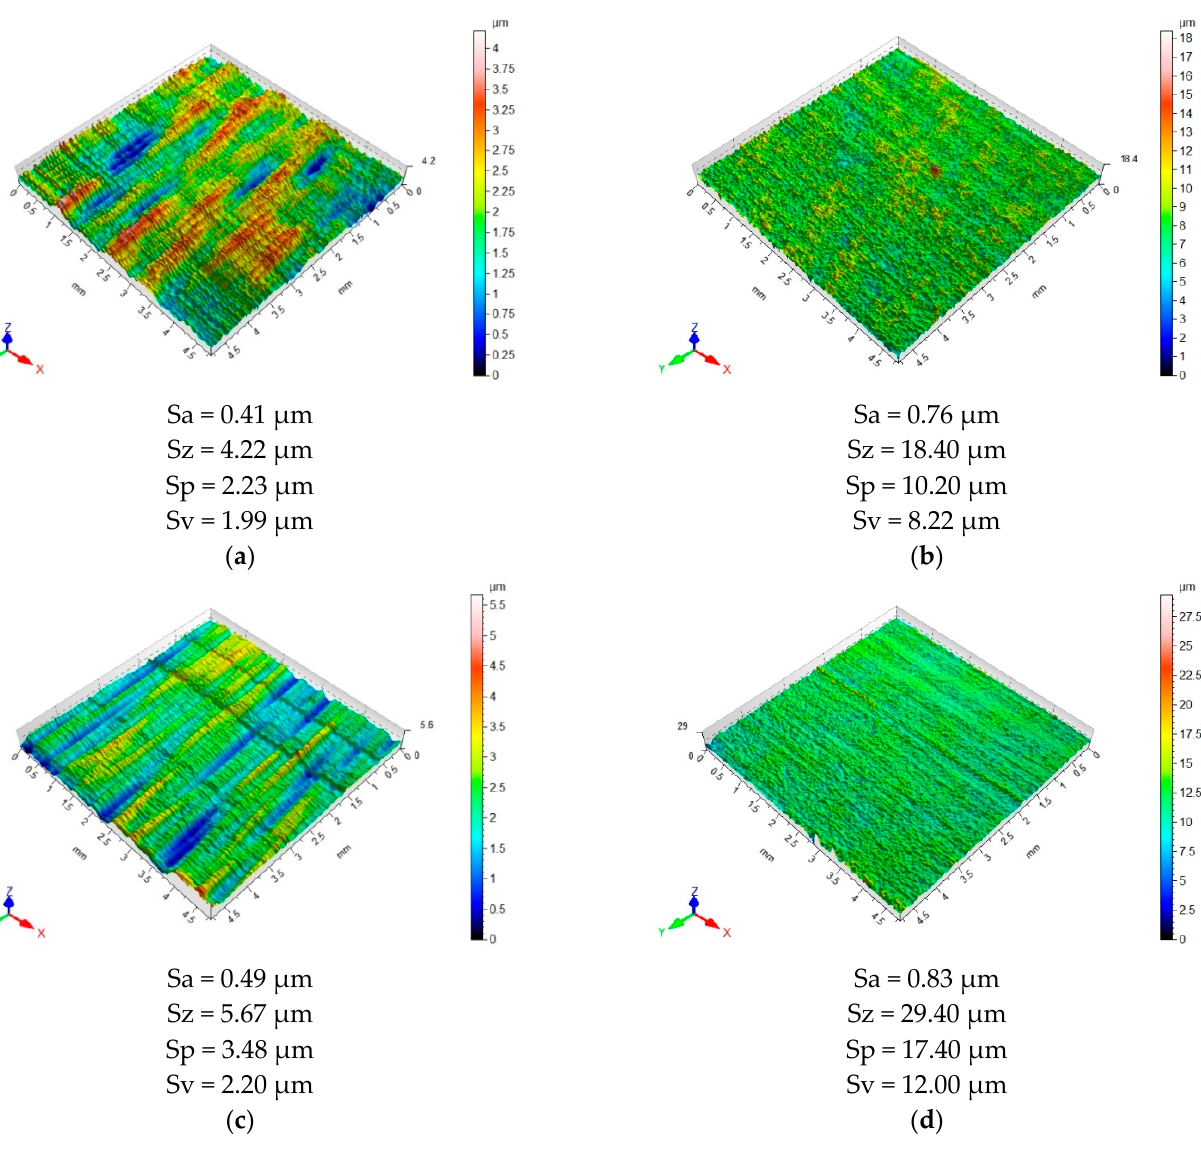
Figure 9. Surface topography after milling: ( a ) aluminum alloy in Al/CFRP configuration using a non-coated tool, ( b ) CFRP composite in Al/CFRP configuration using a non-coated tool, ( c ) aluminum alloy in CFRP/Al configuration using a non-coated tool, and ( d ) CFRP composite in CFRP/Al composite configuration using a non-coated tool.